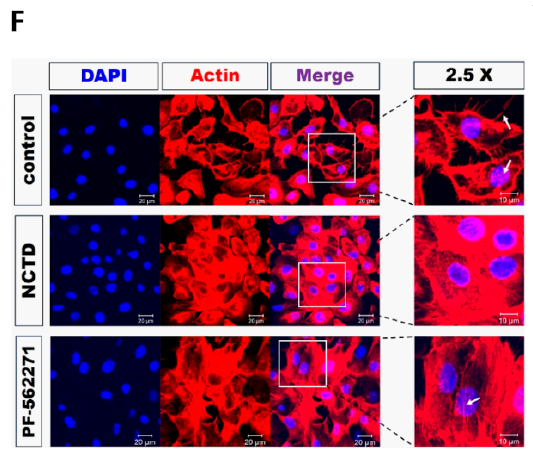
Figure 5. Comparison of the anti-invasive efficacy between NCTD and PF562271 in YD-15 cells. ( A , B ) Wound-healing assay of cell migration after treatment with NCTD or PF562271. ( C ) Transwell assay for the cell invasive potential after treatment with NCTD or PF562271 in YD-15 cells. ( D , E ) Effects of NCTD or PF562271 on MMP activity using gelatin zymography. ( F ) Confocal images of YD-15 cells after treatment with NCTD or PF562271. Graphs show the mean ± SD of triplicate experiments and significance compared with the vehicle control (* p < 0.05).